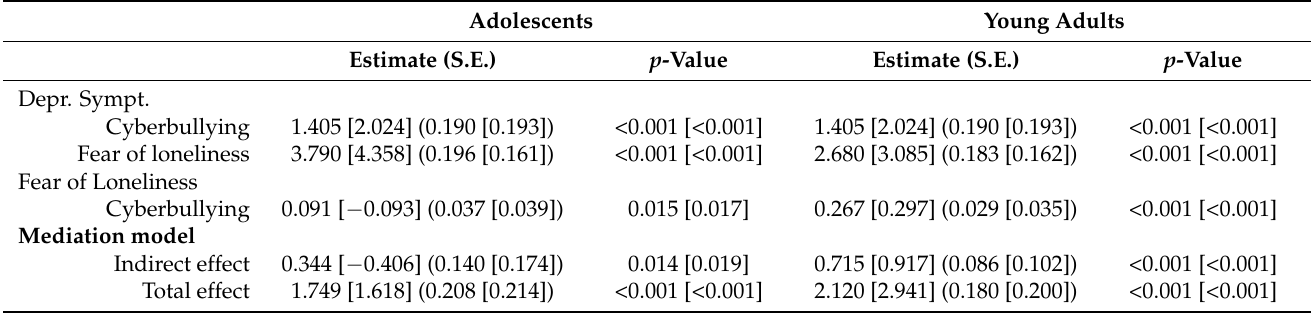
Table 4. Multi-group mediation model parameters predicting depressive symptoms. Adolescents Young Adults Estimate (S.E.) p -Value Estimate (S.E.) p